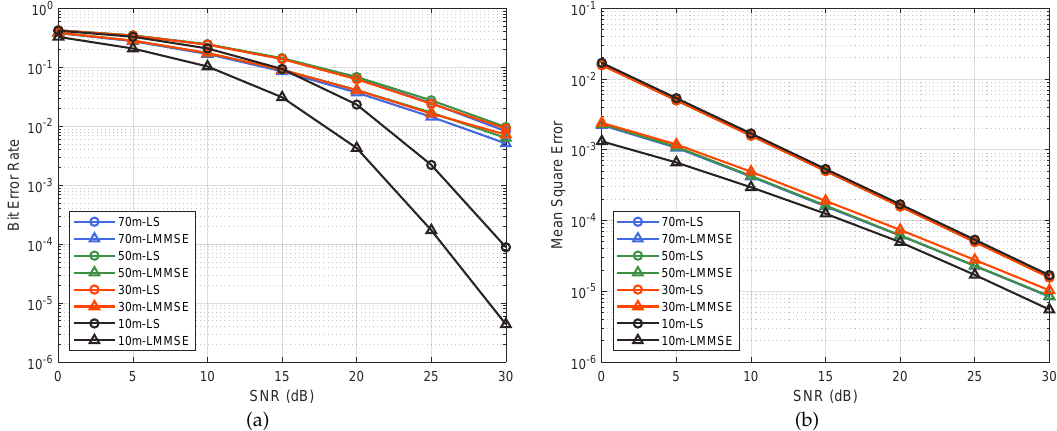
Figure 8. ( a ) bit error rate (BER) performance of channels in different receiving depth, estimated by LS and LMMSE algorithms, respectively. ( b ) MSE performance of channels in different receiving depth, estimated by LS and LMMSE algorithms,